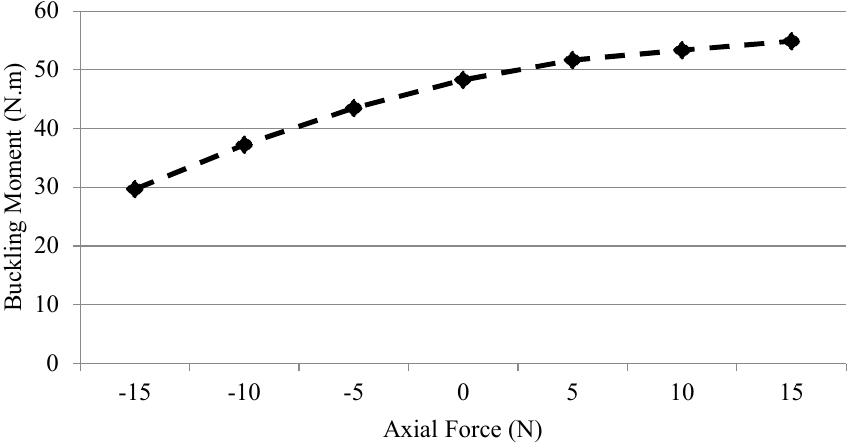
Figure 6. Buckling analysis for a single-layer, glass–epoxy composite, cantilevered beam with a fiber angle of +15 ◦ using a five-element DFE model (negative axial force means compression, while positive means tension).